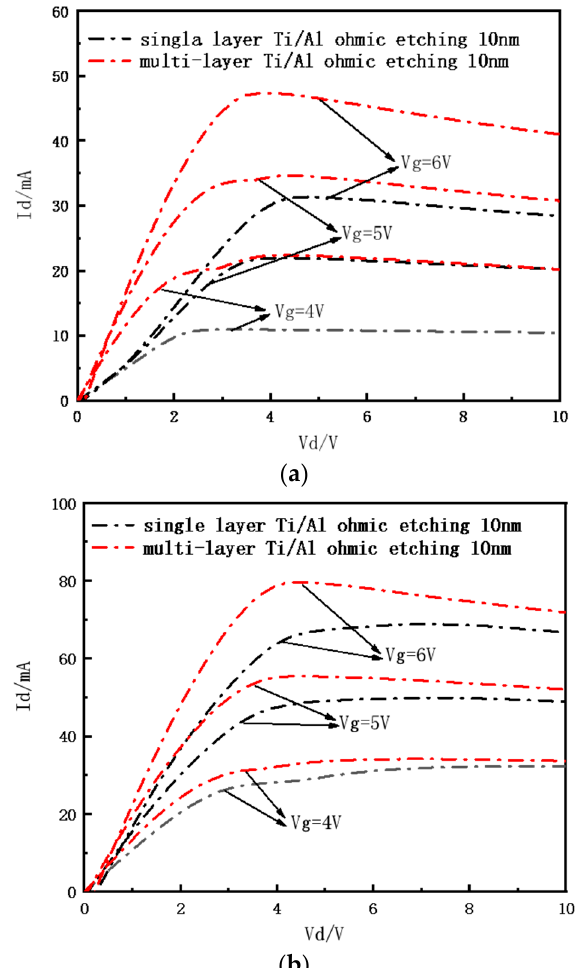
Figure 7. ( a ) Output characteristic curve of conventional structure HEMT device with single and multi-layer electrode when etched depth is 10 nm. ( b ) Output characteristic curve of ring-gate structure HEMT device with single and multi-layer electrode when etched depth is 10 nm.